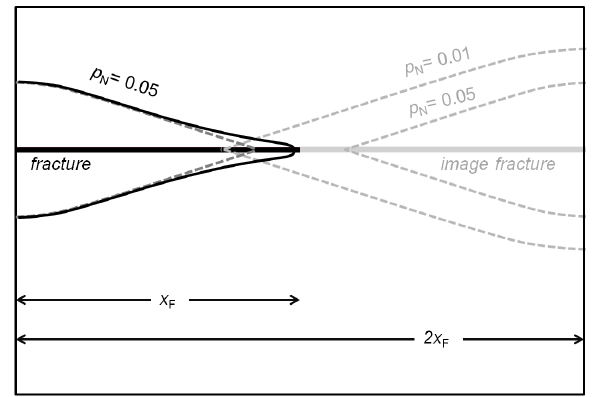
Fig. 5. Evolution of normalized distances x iD /T D τ 1 / 4 (a) and y iD /T D τ 1 / 4 (b) , and of the ratio y iD /x iD (c) as functions of dimen- sionless time τ for normalized isobars p N = 0 . 01 and p N = 0 . 05. Dimensionless fracture conductivity is T D = 0 . 314 in all